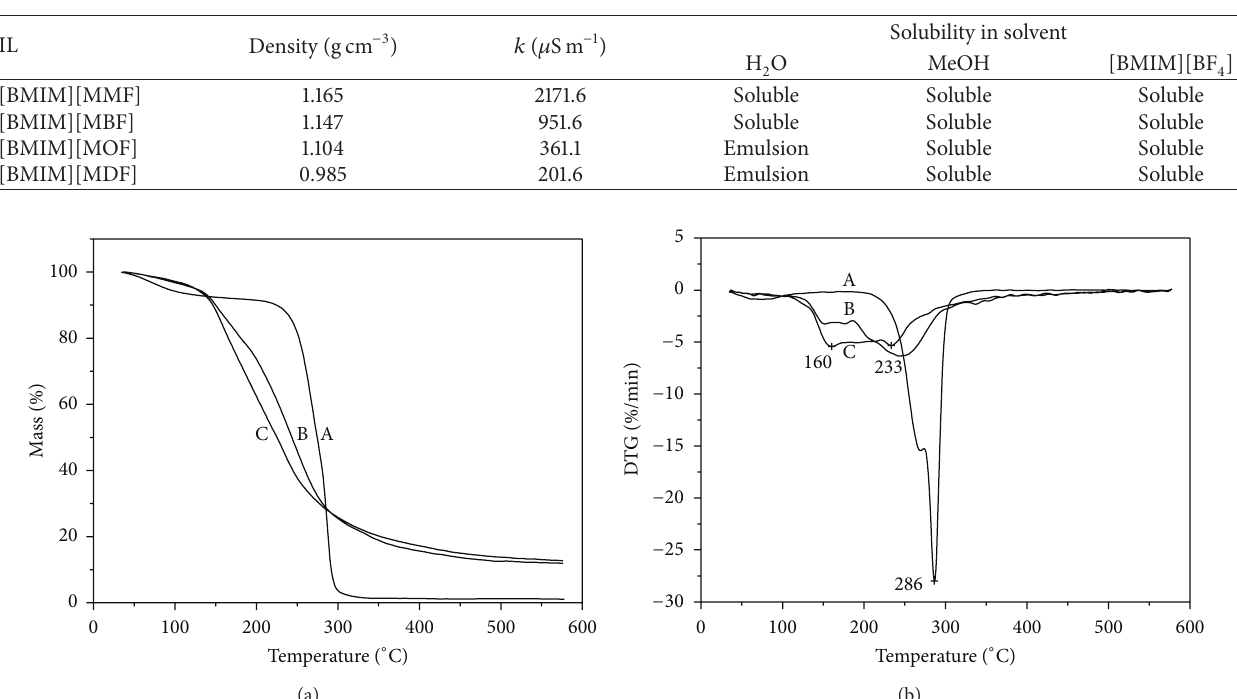
Table 2: Physical properties of ILs with fumarate anion (25 ∘ C).